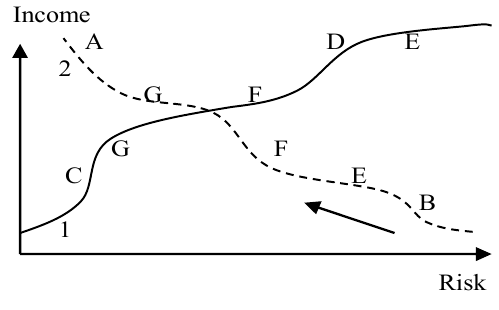
Figure 1. Risk–income ratio.